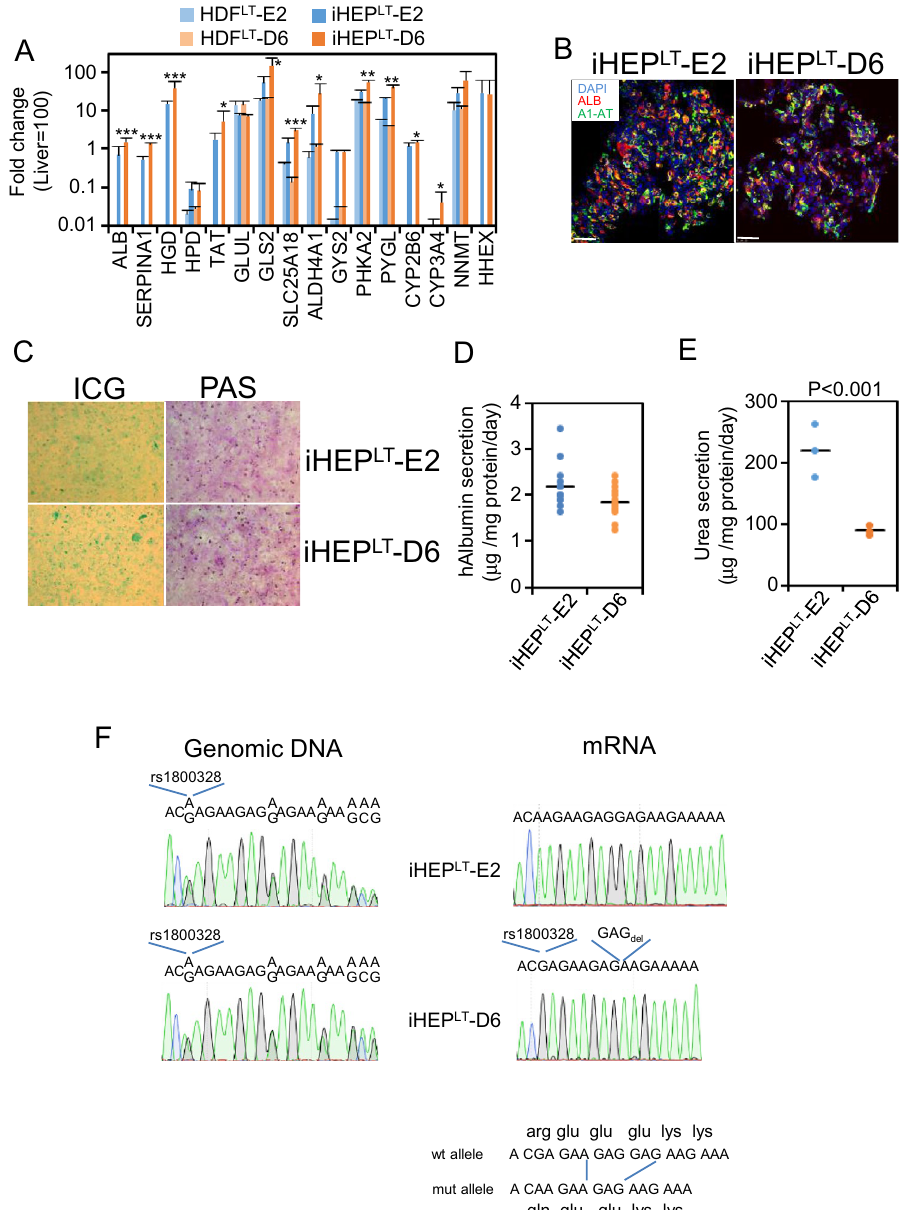
Figure 2. Characterization of iHEP LT in vitro. ( A ) mRNA level of multiple hepatic genes was quantified by qRT- PCR, normalized to PBGD and expressed relative to levels in human liver. *, p < 0.05; **, p < 0.01; ***, p < 0.005; (n = 5 per group). HDF LT were infected with an insert-less lentiviral vector as control. ( B ) Representative fluorescence images of iHEP LT -E2 and iHEP LT -D6 immunostained with antibodies against human albumin and α1-antitrypsin. Nuclei were stained with DAPI. Bar equals 25 µm. ( C ) Indocyanine green uptake and PAS staining. ( D ) Human albumin contained in 24-h cell media quantified by ELISA (n = 13). ( E ) Urea secretion into cell media after 24 h incubation in NH 4 Cl 2 mM (n = 3 per group). ( F ) Sequencing of genomic DNA and retrotranscribed OTC mRNA corresponding to the region of exon 8 containing Glu deletion. Genomic DNA and mRNA was obtained from cultured iHEP LT . Mutant allele (expressed in clone D6) contains also SNP